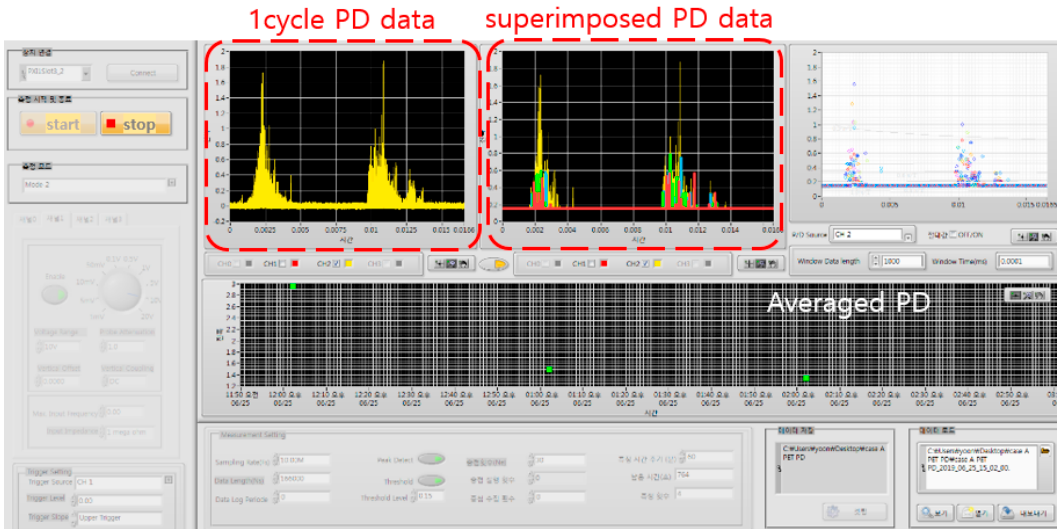
Figure 2. Ameasurementprogramwitha10M / Figure 2. A measurement program with a 10 M/s sampling rate for saving the partial discharge information.